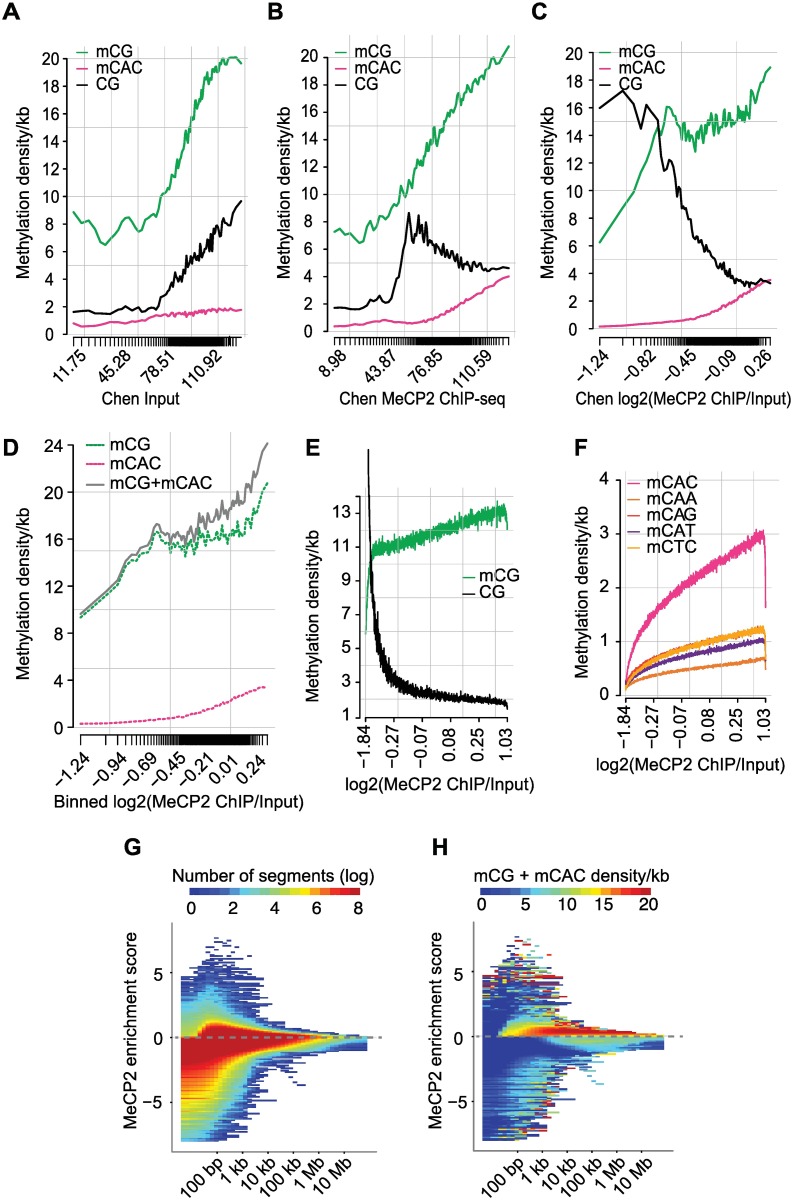
MeCP2 binds to mCG and mCAC in large domains extending beyond the gene scale.(A) Density of mCG/mCAC or unmethylated CG per 1kb as a function of ChIP-seq Input coverage in protein-coding genes. The density of tick marks on the x-axis represents the distribution of genes with respect to Input coverage (datasets from [27] and hypothalamus WGBS from this study). (B) As in (A) but for MeCP2 ChIP-seq read coverage on the x-axis. (C) As in (A and B) but corrected for Input and shown as log2(MeCP2 ChIP/Input) (datasets from [27] and hypothalamus WGBS from this study). (D) As in (C) showing additionally the combined density of mCG + mCAC sites (grey line) (datasets from [27] and hypothalamus WGBS from this study). (E) Relationship between mCG and unmethylated CG density/kb and MeCP2 occupancy corrected for Input in genome-wide 1 kb windows (datasets from [27] and hypothalamus WGBS from this study). (F) Relationship between mCAX and, as a negative control, mCTC density/kb and MeCP2 occupancy corrected for Input in genome-wide 1 kb windows (datasets from [27] and hypothalamus WGBS from this study). (G-H) Domains of MeCP2 enrichment and depletion as determined by MSR (datasets from [27] and hypothalamus WGBS from this study). Grey dotted line indicates zero. (G) Heatmap showing number of segments binned by their scale (x-axis) and MeCP2 enrichment scores (y-axis). X-axis shows the median lengths of segments found with a given scale. Positive scores on the y-axis indicate MeCP2 enrichment; negative scores indicate MeCP2 depletion. The plot is colored according to number of segments. (H) Heatmap showing number of segments binned by scale and scored as in (G). The plot is colored according to combined mCG + mCAC density.